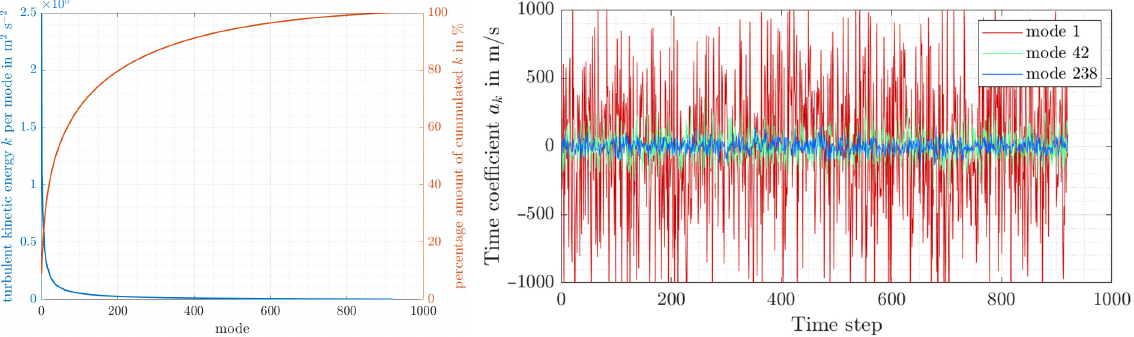
Figure 17. Turbulent kinetic energy per mode and percentage amount of cumulated turbulent kinetic energy ( left ) and time coefficients of the modes 1, 42, and 238 ( right ) at 4 mm and 39.6 kg/h calculated from PIV measurements.